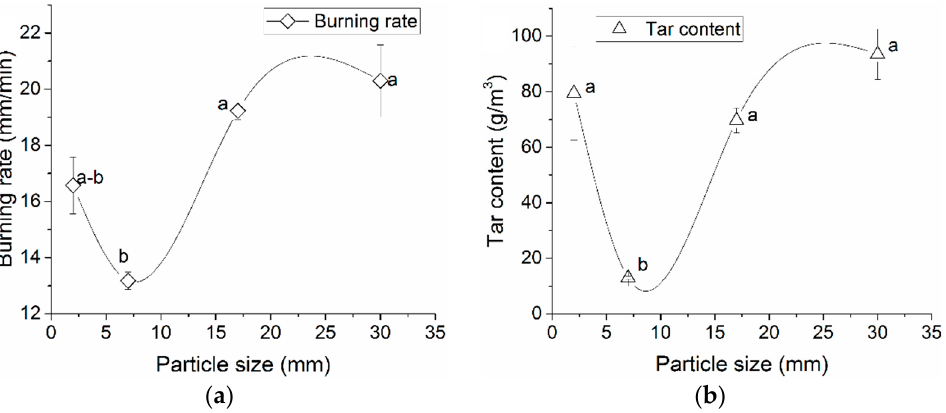
Figure 3. ( a ) Gasification burning rate and ( b ) tar content in syngas at varying particle sizes (airflow rate 20 lpm, moisture content 10%, and biomass compactness 0 kg). Different letters on data points indicate significant differences ( p < 0.05). Table 2. CO and H 2 compositions and the higher heating value of syngas generated at varying particle sizes (airflow rate 20 lpm, moisture content 10%, and biomass compactness 0 kg). CO CH 4 Particle Size H 2 (% v / v ) (% v / v ) (% v / v ) (mm)